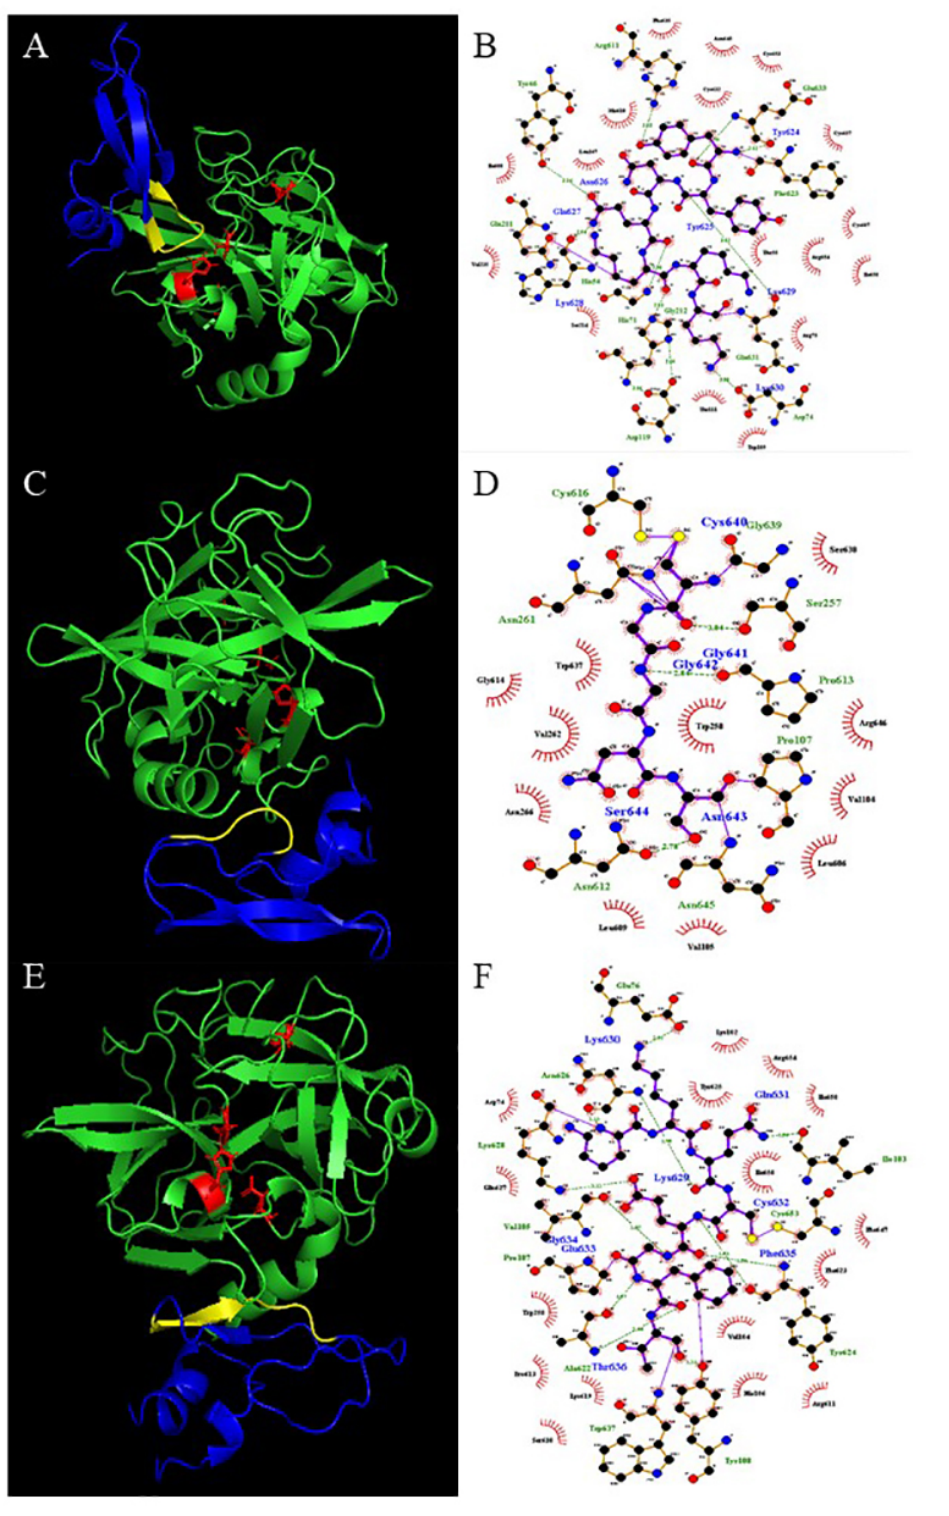
Figure 5. (A) Z-DOCK 3D model, Kunitz-type peptide in blue (YNQKKKQ region in yellow), elastase-1 in green and the amino acid residues of the catalytic triad plus the S 214 in red. (B) LigPlot 2D representation of the interactions of the YNQKKKQ region of the peptide and peptidase. (C) z-dock 3D model, peptide in blue (CGGNS region in yellow), elastase-1 in green and the amino acid residues of the catalytic triad, plus the S 214 in red. (D) LigPlot 2D representation of the interactions of the CGGNS region of the peptide and peptidase. (E) Z-DOCK 3D model, peptide in blue (KKQCEGFT region in yellow), elastase-1 in green and the amino acid residues of the catalytic triad plus the S 214 in red. (F) LigPlot 2D representation of the interactions of the KKQCEGFT region of the peptide and